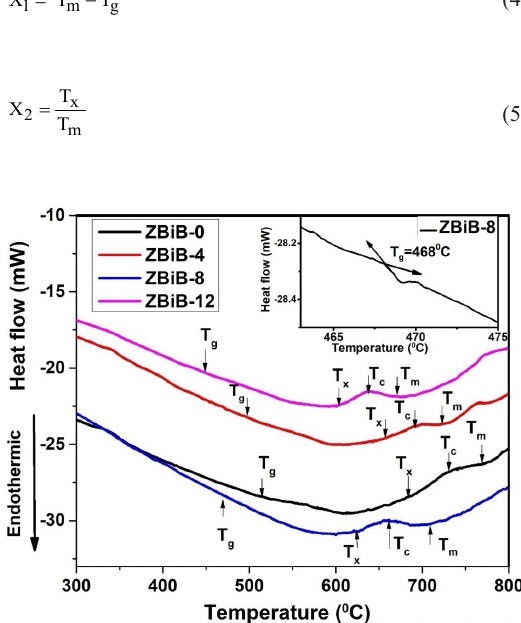
Figure 1. DTA curves of ZBiB-0,4,8,12 glasses in the temperature range of